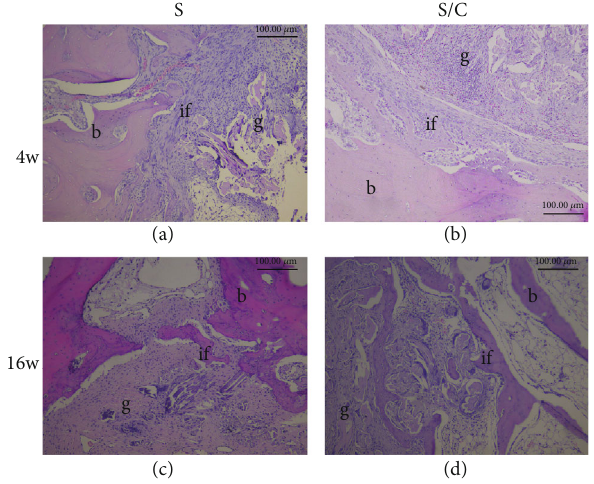
Figure 7: HE staining of the graft – bone interface for histological observation. At 4 weeks after the reconstruction surgery, no obvious bone integration was noticed in the two groups; although, more cells were distributed in the core part in the S/C group (b) than in the S group (a). At week 16, mature trabecular bone and considerable cell invasion in the sca ff old could be noticed at the graft – bone interface in the S group (c). In the S/C group, integration of the trabecular bone into the graft was observed (d).